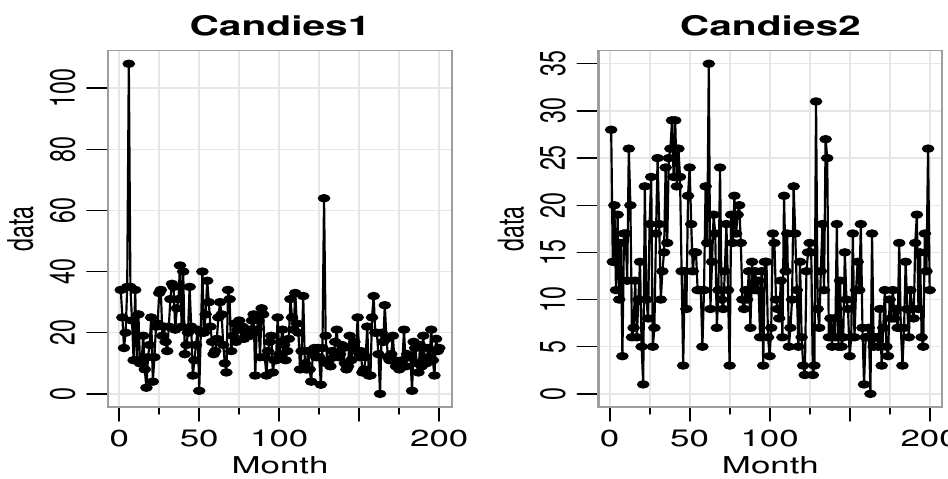
Figure 7. The time series plot of Candies1 and Candies2 data.